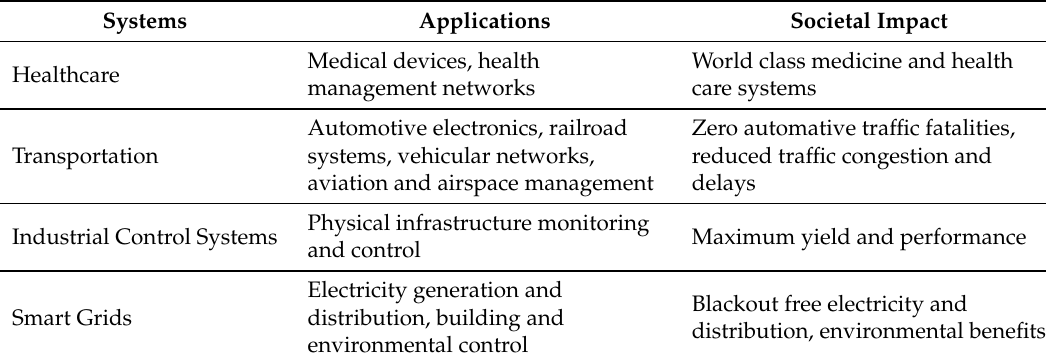
Figure 6. Four applications of CPS surveyed in this paper. Table 1. Application domains of